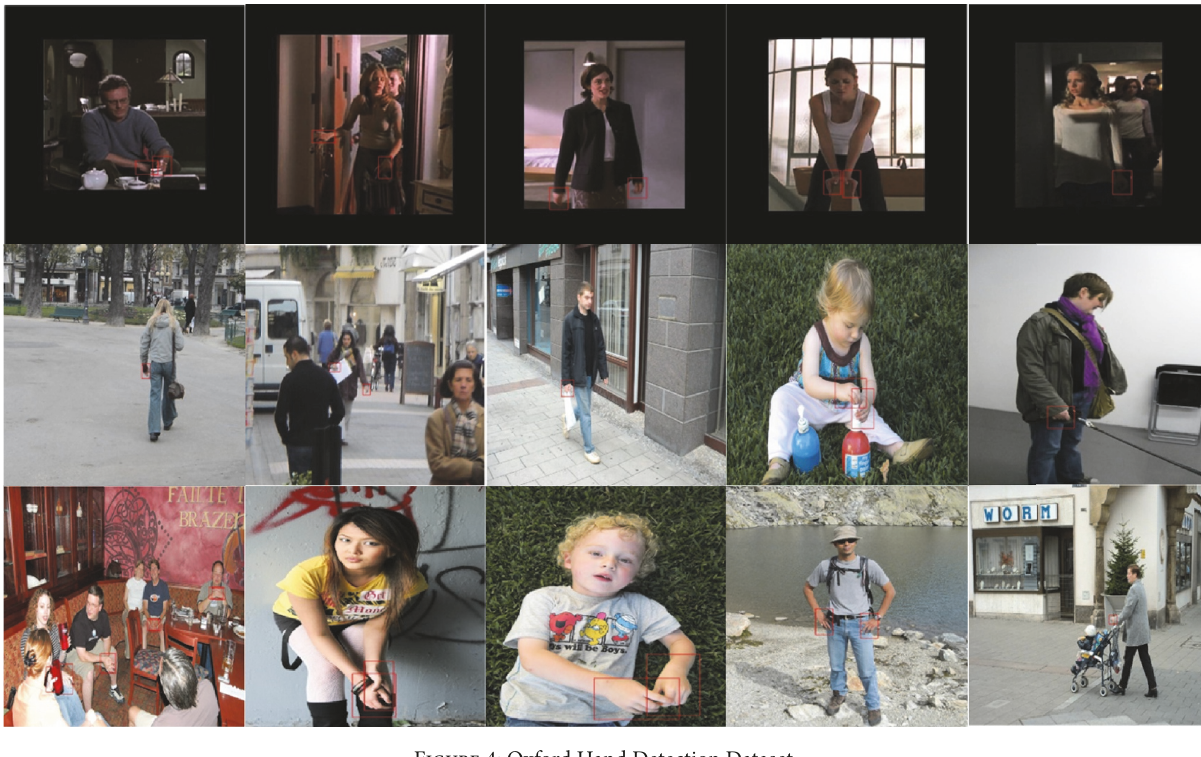
Figure 4: Oxford Hand Detection Dataset.